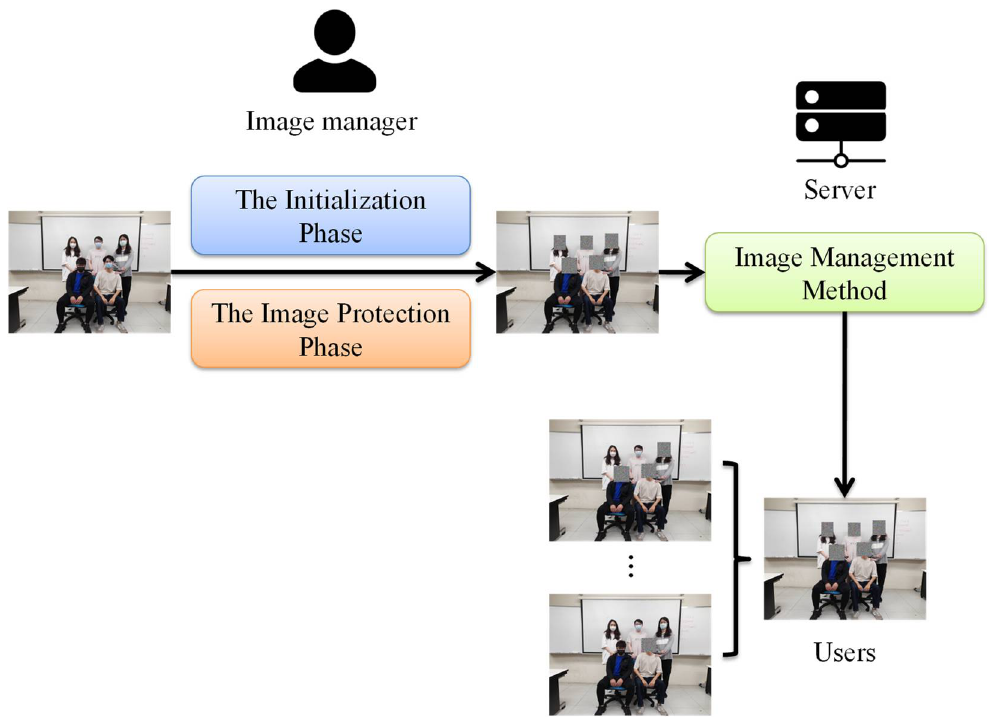
Figure 1. A framework for supporting different privacy-preserved access rights in a single image.